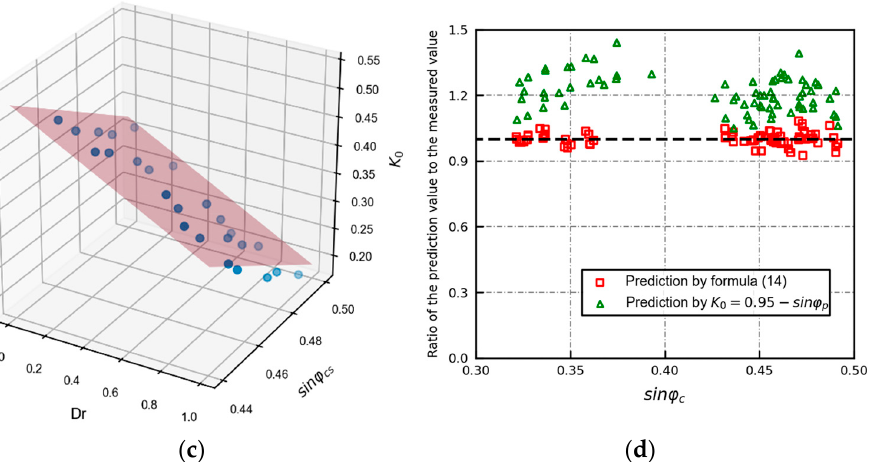
Figure 16. Comparison between the predicted K 0 values and the measured ones; ( a ) Aspect ratio=1; ( b ) Aspect ratio=1.3; ( c ) Aspect ratio=1.7; ( d ) Comparison for all points.